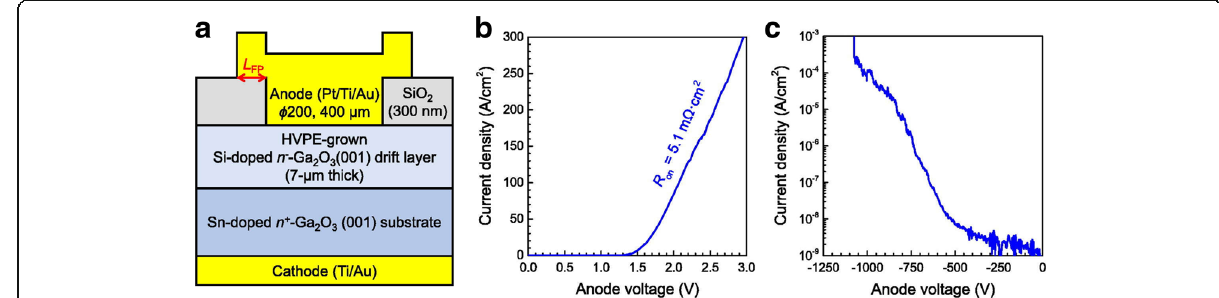
Fig. 9 a Structure of the SBD with field plate. b , c Forward and reverse electrical characteristics ( V br = 1076 V). Reprinted from ref. [68]